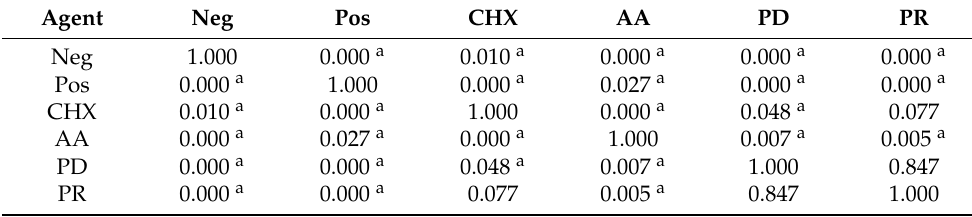
Table 3. Pairwise comparison table of antimicrobial activity on Essix ® specimens.